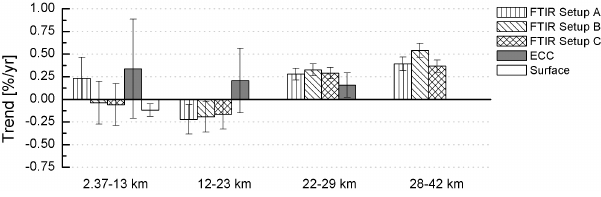
Fig. 12. Linear trends (%yr − 1 ) between 1999 and 2010 for the FTIR ( N = 1887), the corrected ECC sonde ( N = 515) and surface in situ ( N = 42415) datasets. The error bars indicate the 95% con- fidence ranges ( ± 2 σ